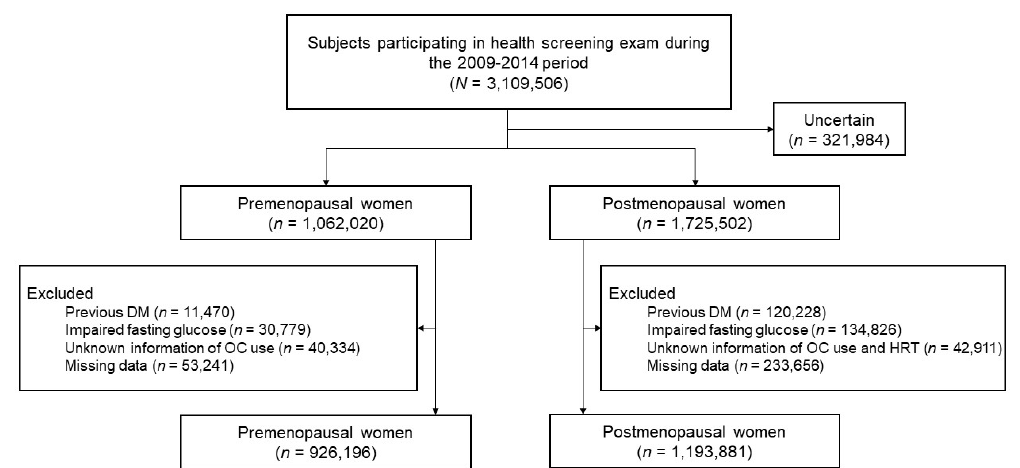
Figure 1. Flow chart of the study population.